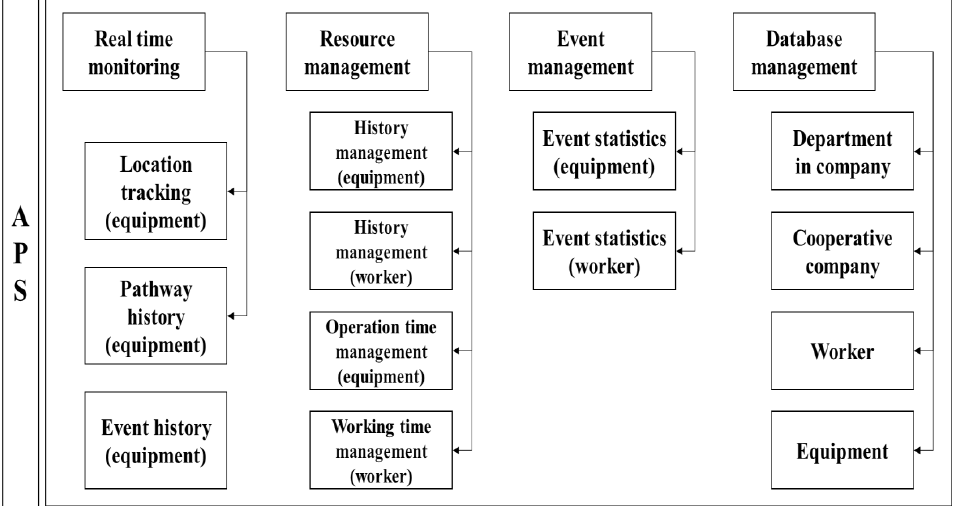
Figure 4. Accident prevention solution (APS) data architecture.